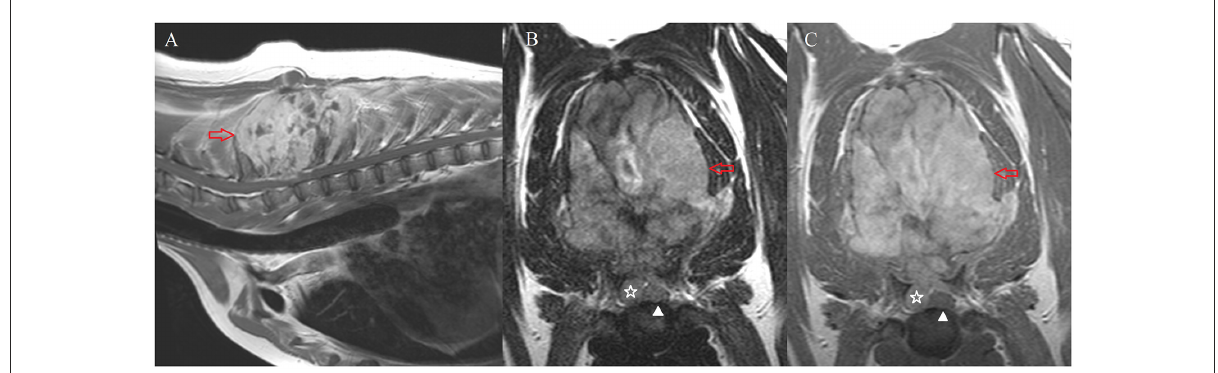
FIGURE1 MRI of case #72. Sagittal T1-weighed post-contrast image of the caudal cervical and cranial thoracic vertebral column (A) transverse T2-weighted (B) and transverse T1-weighted post-contrast (C) images at the level of T1-T2. A large, irregular and well-defined mass lesion involving the dorsal spinous processes of T1-T4 vertebrae is shown (red arrow). This mass is markedly heterogeneous on T2-weighted images (B) and shows marked enhancement in T1-weighted images after intravenous administration of gadolinium-based contrast agent (A,C) . The mass showed extradural extension causing moderate spinal cord compression (star). The white arrowhead indicates the position of the spinal cord. On post-mortem examination, this mass was classified as a chondroblastic osteosarcoma.